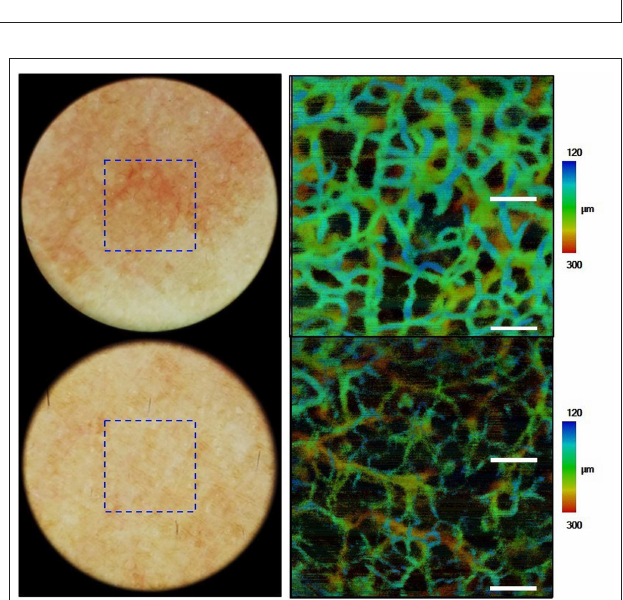
FIGURE 9 | Images of nevus flammeus and normal skin acquired by dermoscopy-guided angiographic optical coherence